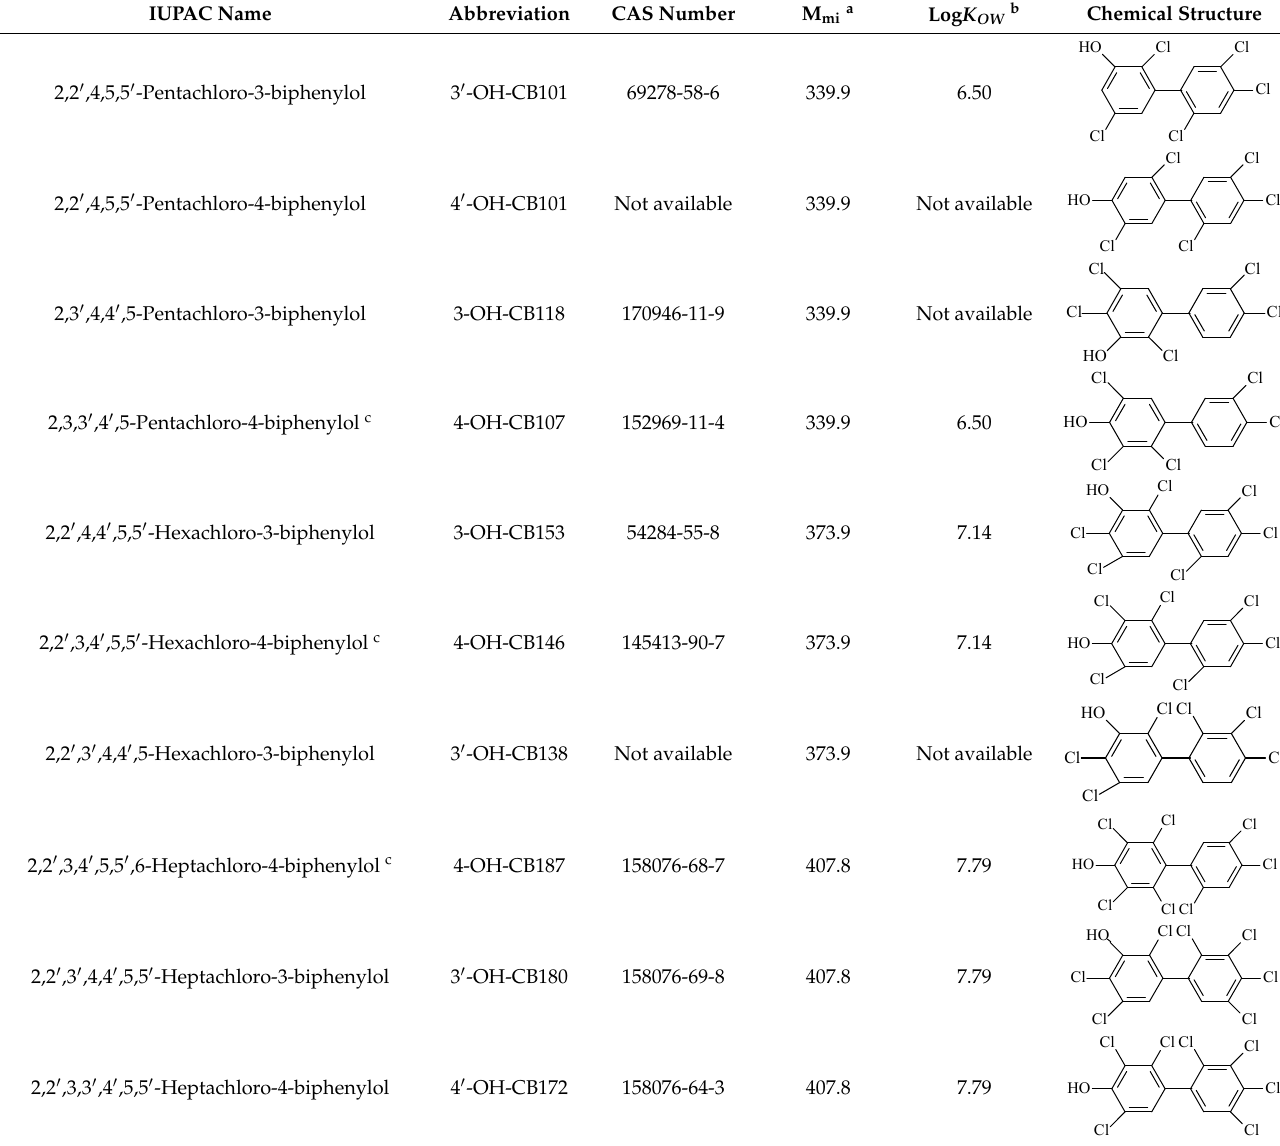
Table 2. Characteristics of the selected OH-PCBs.